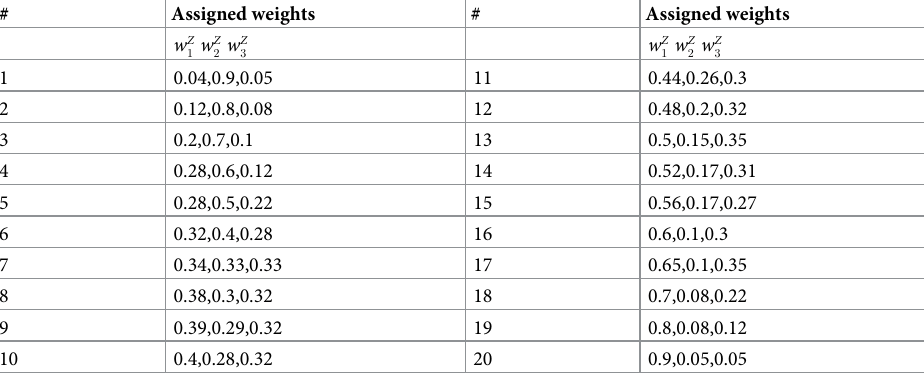
Table 12. Assigned weights of objective function in LP-metrics method.